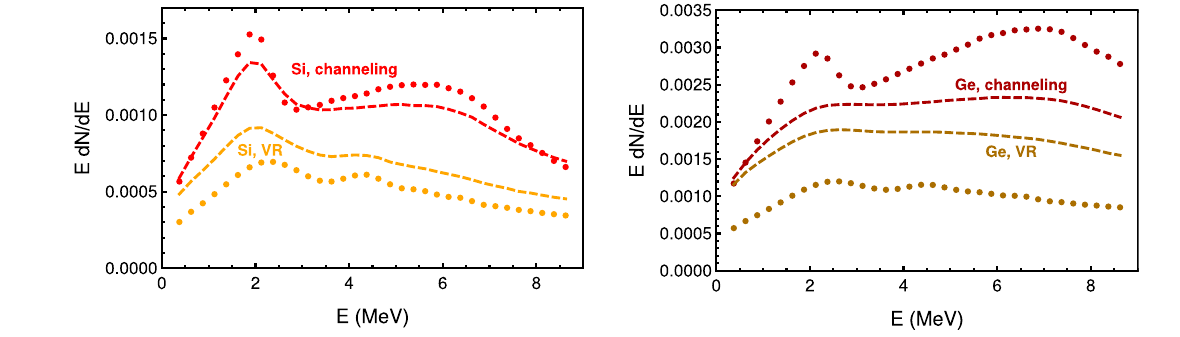
820 µ rad for Ge as in Fig. 2a. The incoherent scattering is taken (not taken) into account in the dashed (dotted) line